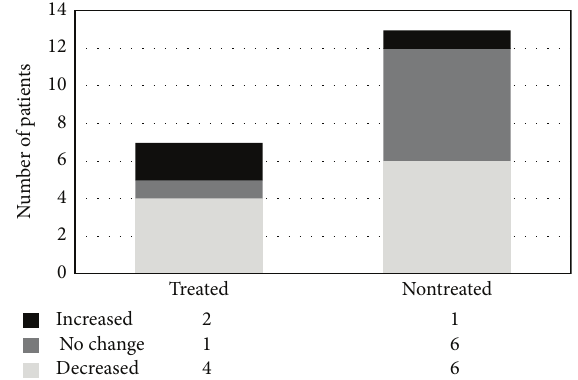
Figure 2: Changes in proteinuria as determined by a urine dipstick test and classified by antiviral treatment. Decrease in proteinuria between the intervention group and the control group was not considered statistically significant ( 𝑃 = 0.143